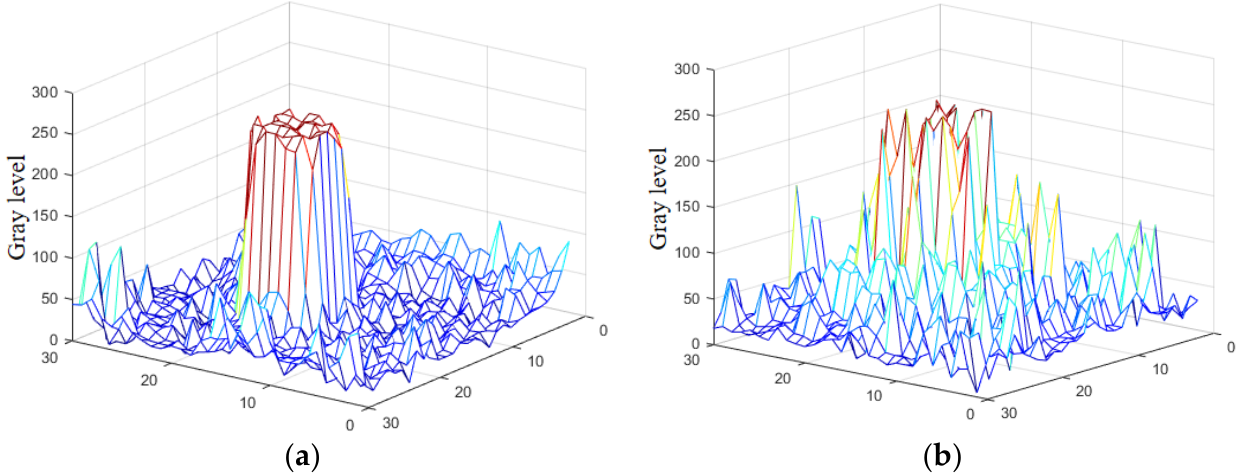
Figure 5. Three-dimensional view of the pixel values belonging to real and pseudo targets. ( a ) True target local pixel value and ( b ) partial pseudo-target local pixel value.